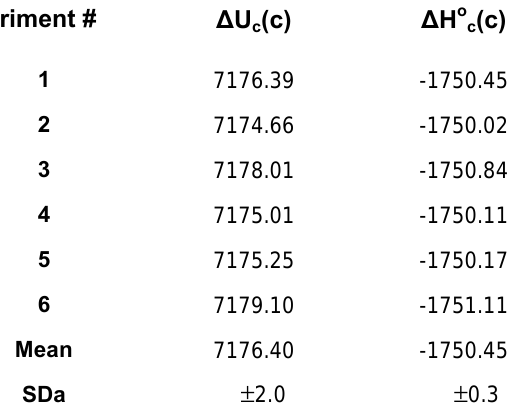
in (cal/grade) and Normal Combustion Enthalpies ( ∆ H o Experiment